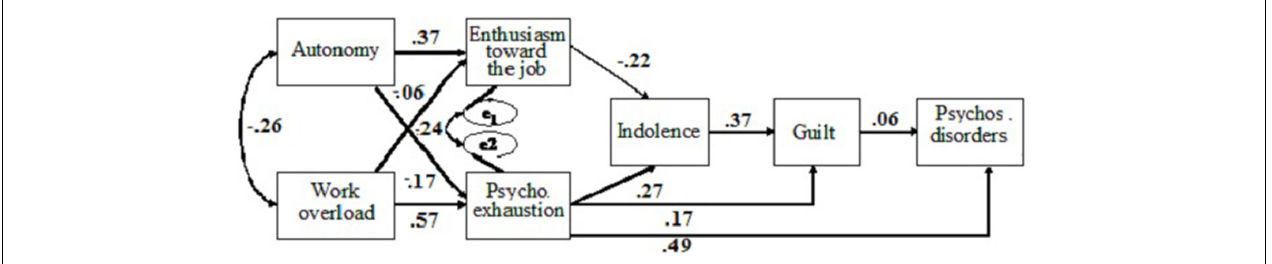
FIGURE 2 | Standardized coefficients for the modified model, taking into consideration feelings of guilt as predictor of psychosomatic disorders for the Spanish sample.